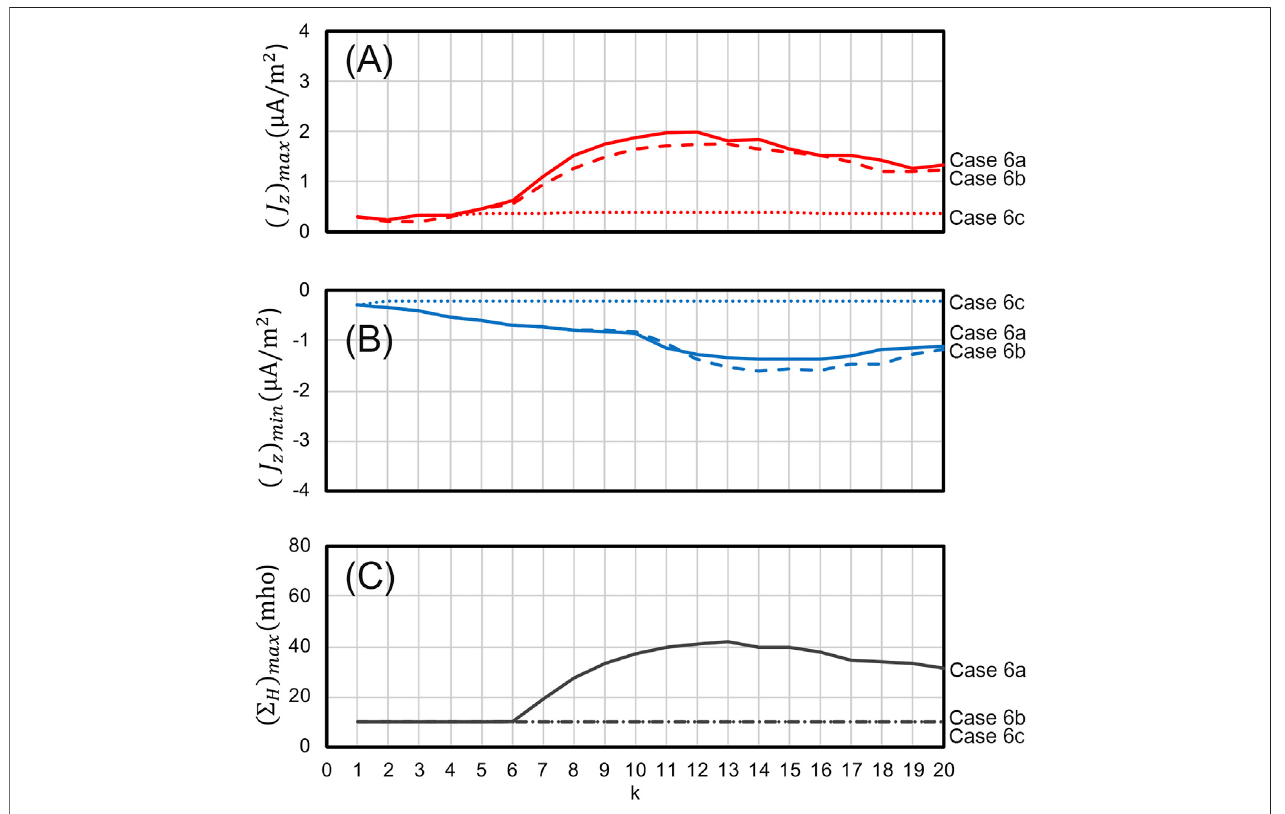
FIGURE 8 | The time evolution of the (A) ( J z ) max , (B) ( J z ) min , and (C) ( Σ H ) max obtained from Case 6a (the solid curves), Case 6b (the dashed curves), and Case 6c (the dotted curves) simulations. The initial distributions of the conductances of the three cases are nonuniform and are similar to the one used in Cases 1 – 3. The conductance enhancement scheme in the ionosphere is turned off in the simulation study of Case 6b. The plasma sheet Hall effect is turned off in the simulation study of case 6c.